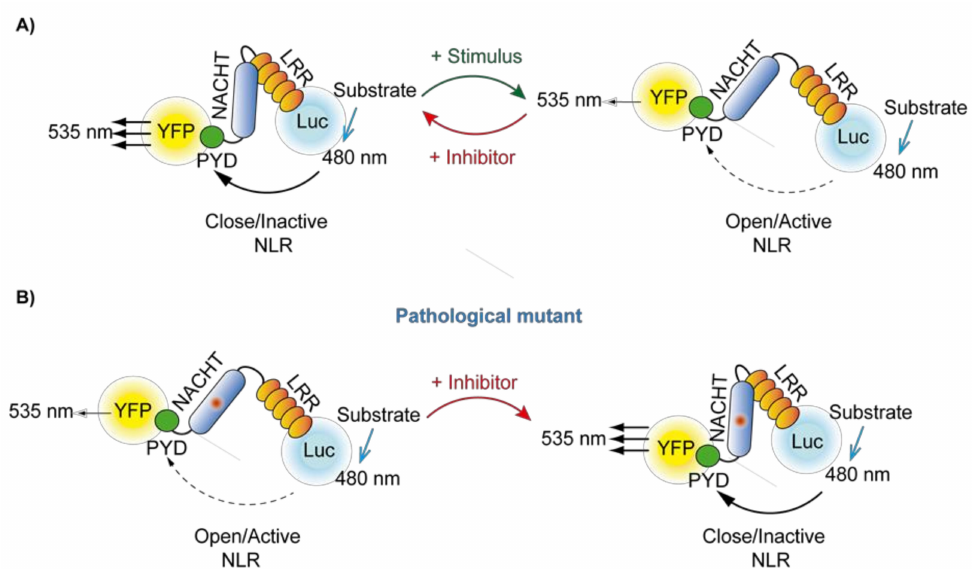
Figure 4. Schematic representation of the Bioluminescent Resonance Energy Transfer (BRET) technique. ( A ) When using NLR tagged with YFP and luciferase (Luc) at both N- and C-terminus, the recorded BRET signal could variate when an inactive/closed conformation changes to an active/open conformation after stimulation. The BRET signal could also change in the presence of an inhibitory molecule. This method could not only be used as a screening assay, as it can be easily scaled up, but also could be used to depict the mechanism of action of inflammasome inhibitors. ( B ) If the NLR BRET sensor depicted in ( A ) includes a pathological mutant, the basal conformation is already in an auto-active state. If the mutant NLR is treated with an inhibitor, the BRET signal will change. Of note, this method will only function if the inhibitor is able to significantly alter the conformation of the mutant